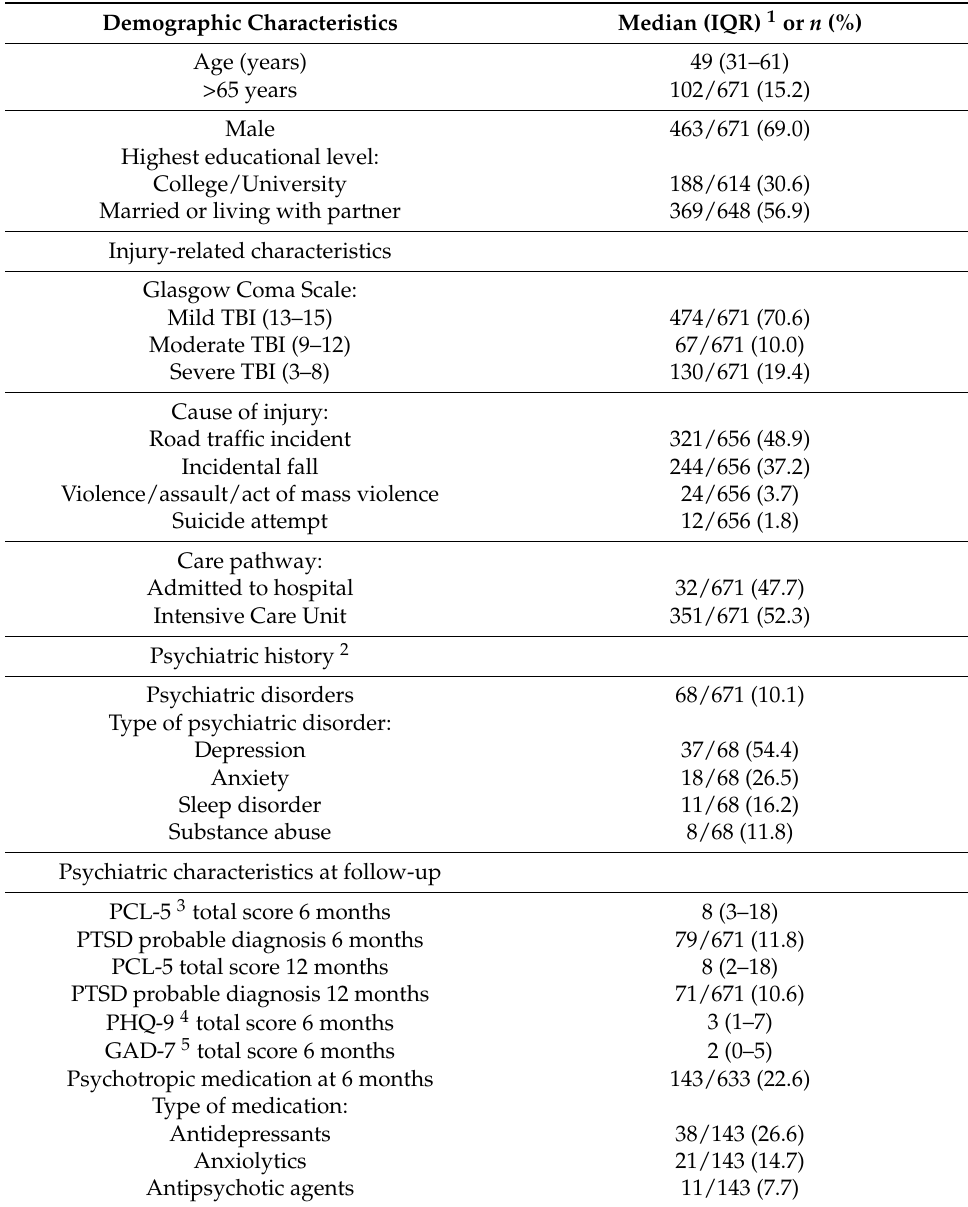
Table 1. Participant characteristics ( n =